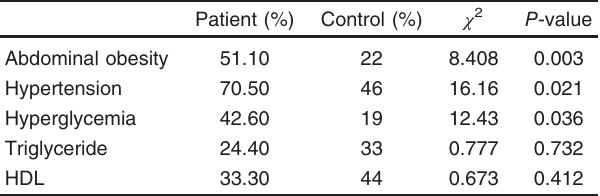
Table 7 The parameters of metabolic syndrome in patients and